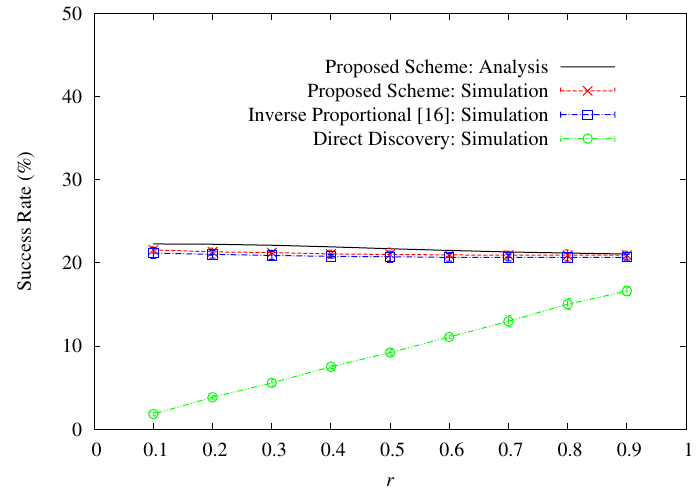
Figure 8. Discovery success rates of different schemes.